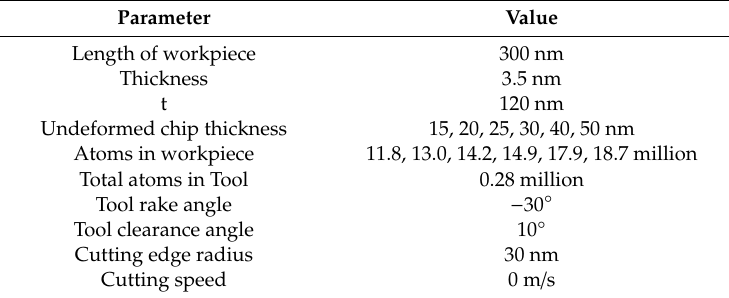
Figure 1. MD models of orthogonal cutting under a series of t uc . Table 1. MD Simulation parameters of orthogonal cutting.